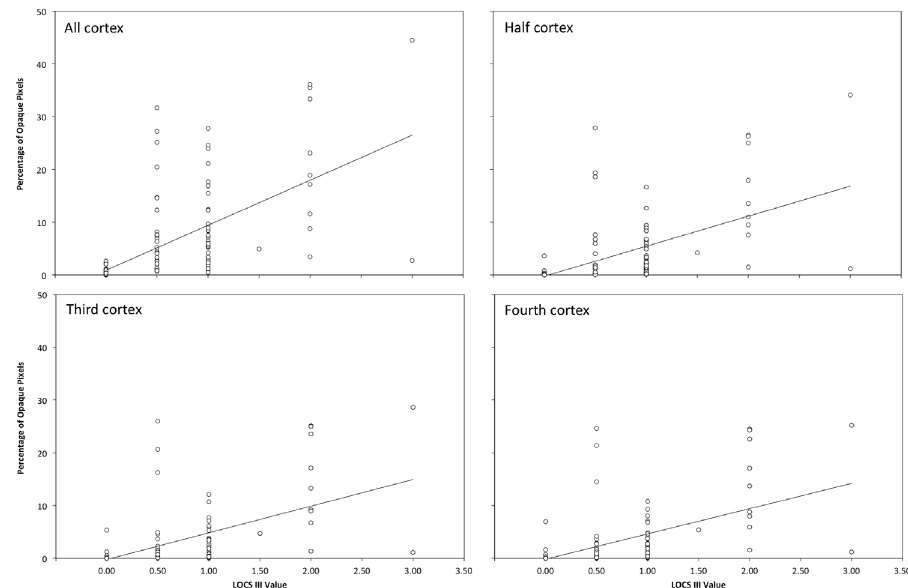
Fig 5. Scatter Plot Representing the Relationship between the Percentage of Opaque Pixels and LOCS III Grade for each Region of Interest Size. Top left panel corresponds to the whole mask size; top right panel does the whole mask size; bottom left panel does third mask size; and bottom right does quarter mask